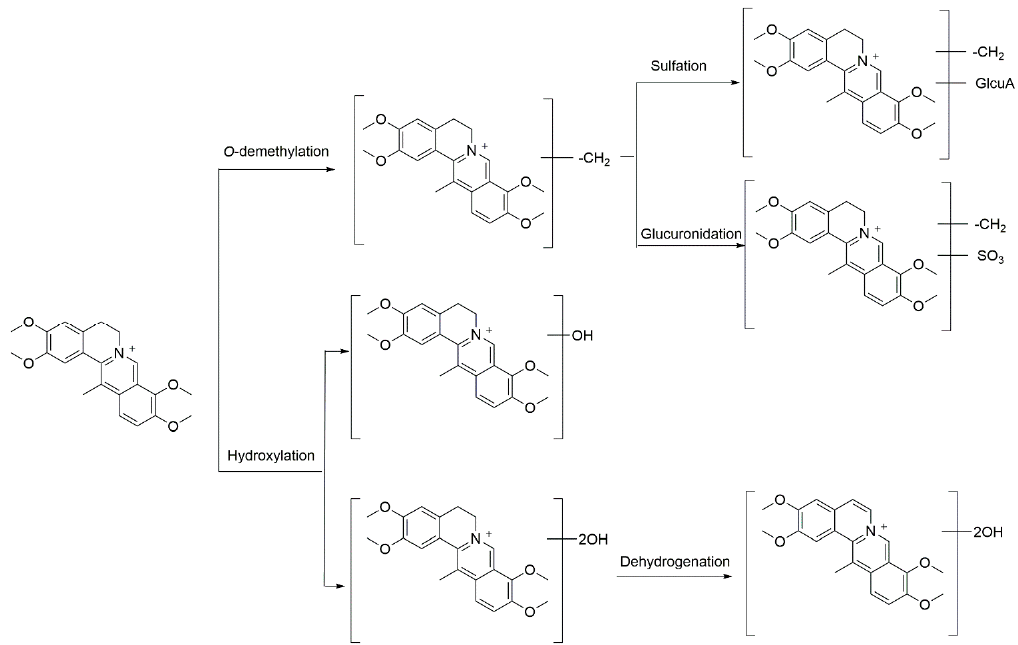
Figure 9. Proposed metabolic pathways of dehydrocorydaline (DHC) in rats.